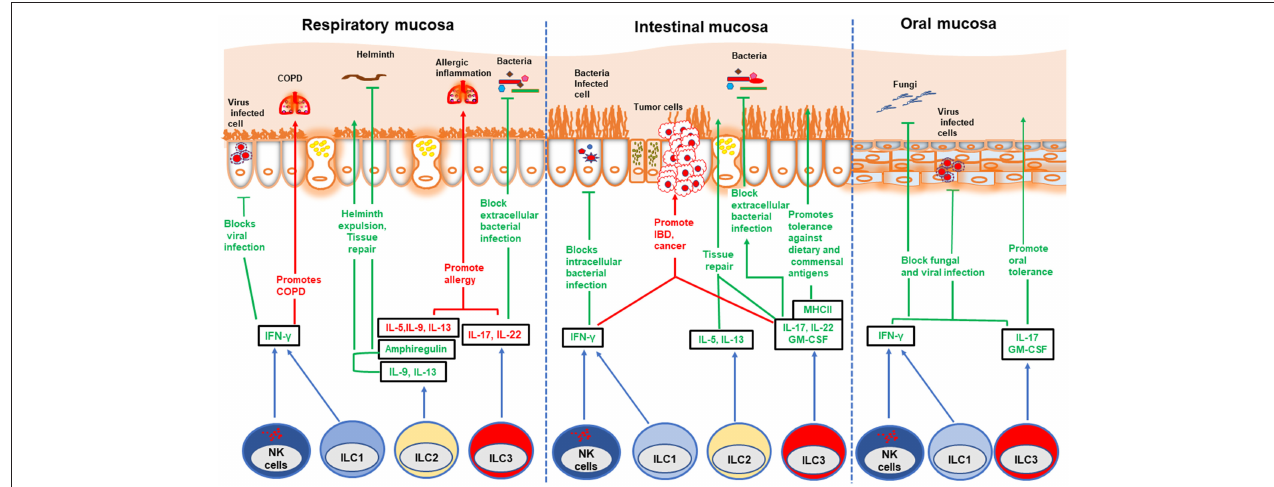
FIGURE 1 | Role of ILCs in different mucosae. Different ILC subsets play beneficial and detrimental roles in different mucosae: protection against various infections, tolerance against innocuous antigens, induction of allergy, IBD, and cancer. NK cells and ILC1s block viral and intracellular bacterial infections by secreting IFN- γ . However, ILC1s promote COPD and IBD in respiratory and intestinal mucosa, respectively. ILC2s contribute to worm expulsion and tissue repair in both respiratory and intestinal mucosa during helminth infection. Further, these cells repair viral induced lung injury by secreting amphiregulin. On the other hand, ILC2s promote allergic inflammation in lung and nasal polyps. ILC3s play dual role in both respiratory and intestinal mucosa. These cells confer protection against extracellular bacterial infection by secreting IL-22 which induces production of anti-microbial peptides by epithelial cells. ILC3s block oral fungal infection in an IL-17-dependent manner. These cells also promote tolerance against commensal and dietary antigens through MHC-II mediated antigen presentation. However, inappropriate activation of ILC3s can play a detrimental role by instigating allergy in the respiratory mucosa, as well as IBD and cancer in the intestinal